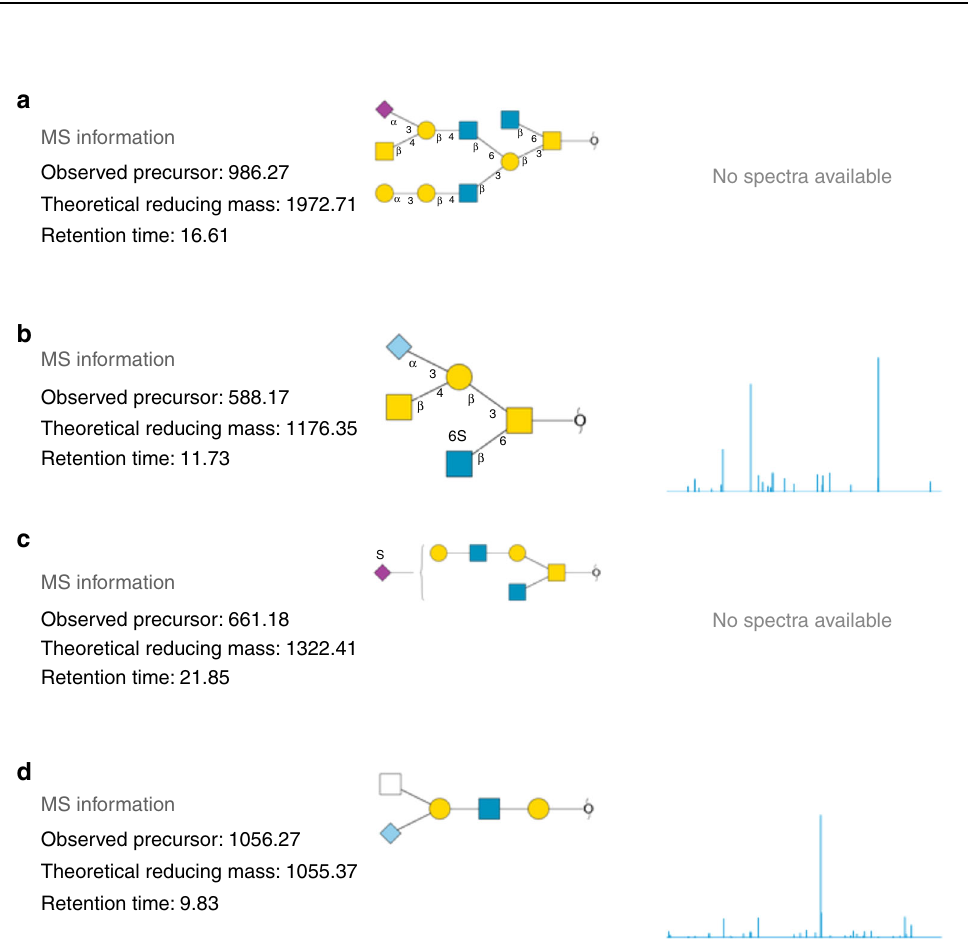
Fig. 3 Different types of entries managed by the UniCarb-DR submission tool. The glycan structures are displayed in SNFG cartoon notation 83 . a Structure proposed from LC-MS without an LC-MS/MS spectrum. b Fully assigned structure with an associated LC-MS/MS spectrum. c Partially assigned structure proposed from LC-MS without an LC-MS/MS spectrum. d Partially assigned structure with an associated LC- MS/MS